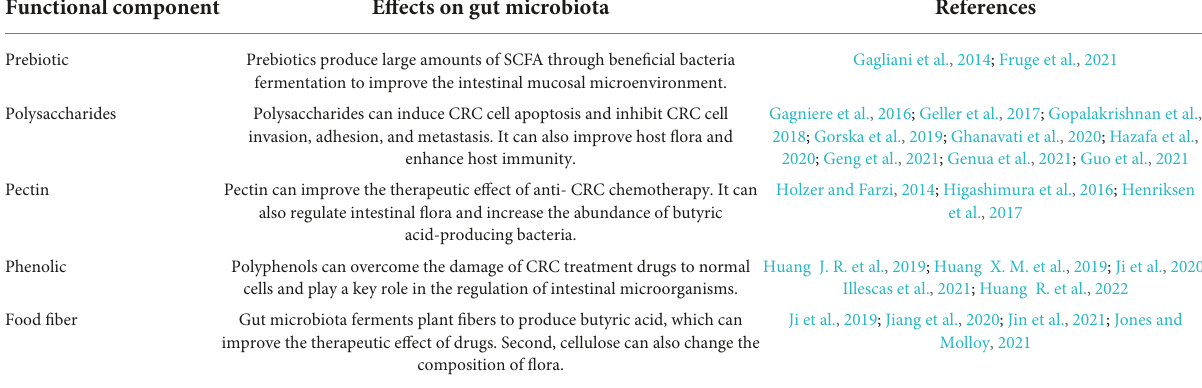
TABLE 1 This chart summarizes the effects of prebiotic on gut microbiota, and directly or indirectly plays a role in